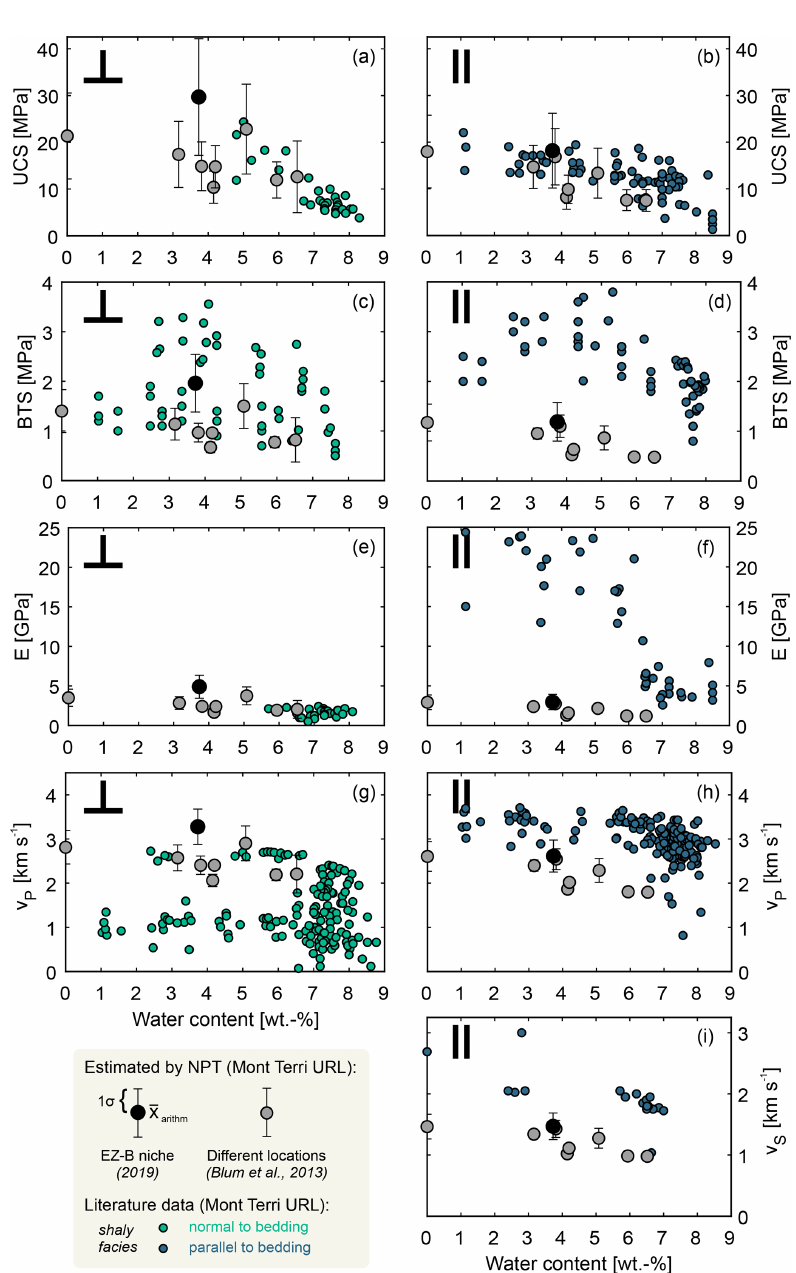
Figure 6. Comparison of estimated geomechanical and geophysical parameters of the Opalinus Clay in the EZ-B niche of the Mont Terri URL (black symbols, this study) with literature data for the shaly facies normal (a–g) and parallel (b–i) to bedding. In addition, a second NPT dataset of Blum et al. (2013) from various locations in the URL (shaly facies) is shown (gray symbols). Literature data (green and blue symbols) originate from other niches in the Mont Terri URL and are mainly adapted after Jaeggi and Bossart (2014) and references herein (the full list of source documents is provided in Appendix